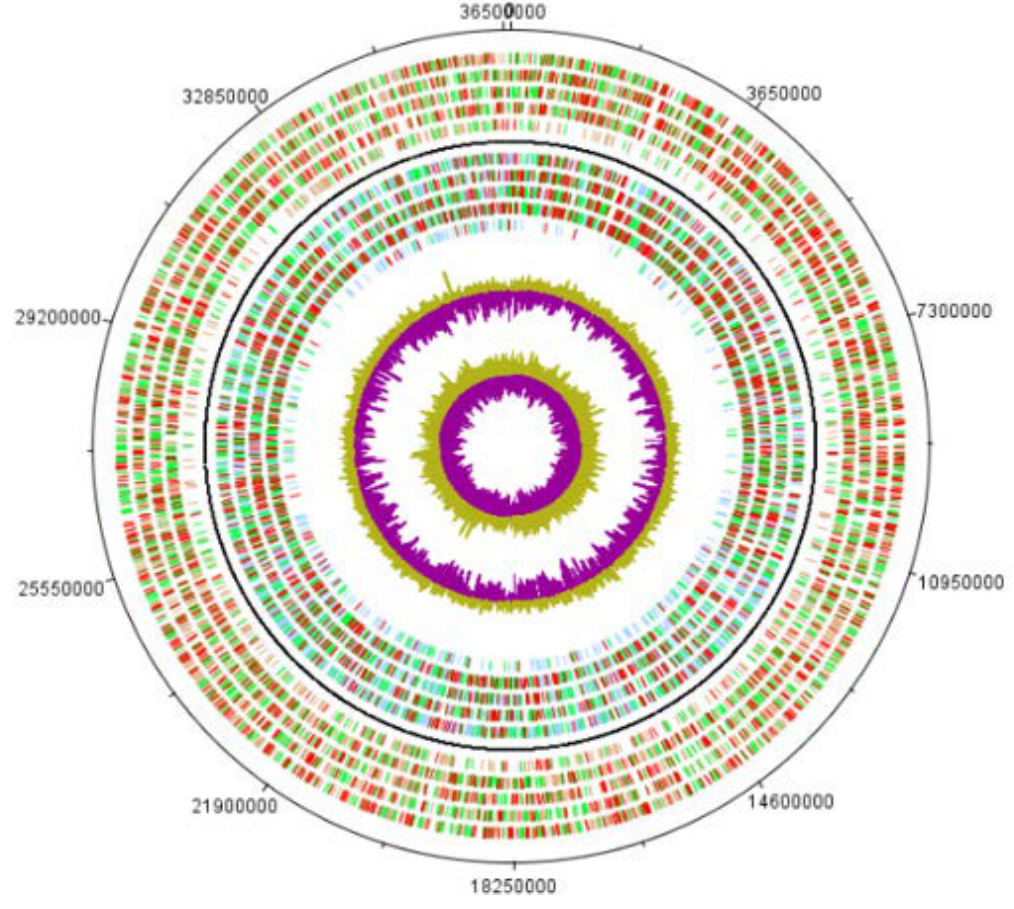
Figure 2. Circular map of the W. magna genome. Outside circle: genes on the forward strand colored by light brown are predicted genes; green bars are transcripts and red are proteins. Second to outside circle: genes on the reverse strand colored by light blue are predicted genes; green bars are transcripts and red bars are proteins. In the center: GC content and GC skew.